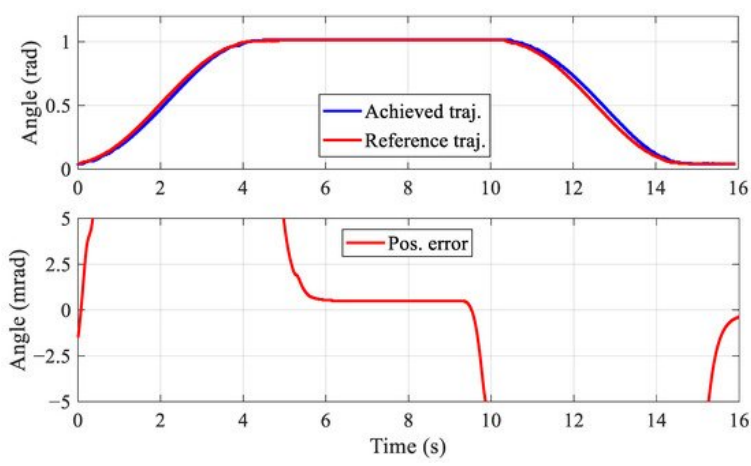
Figure 11. Achieved and reference trajectory and error for the first axis [17].